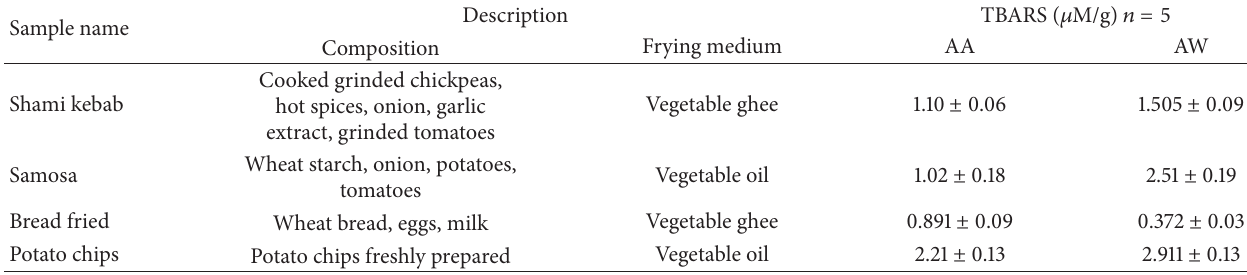
Table 3: Thiobarbituric acid reactive substances (TBARS) in fried fast foods samples. AA is 100% acetic acid, while AW is 50% acetic acid in